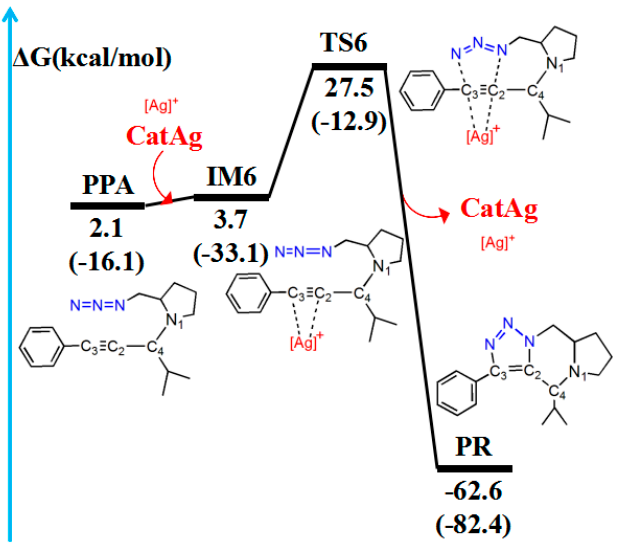
Figure 9. Pathway for the cycloaddition reaction between the triple bond and the − N 3 group in PPA. The relative free energy of the reaction pathway involving hydrogen is provided in kcal/mol. The relative enthalpy is also provided in brackets for reference (in kcal/mol).